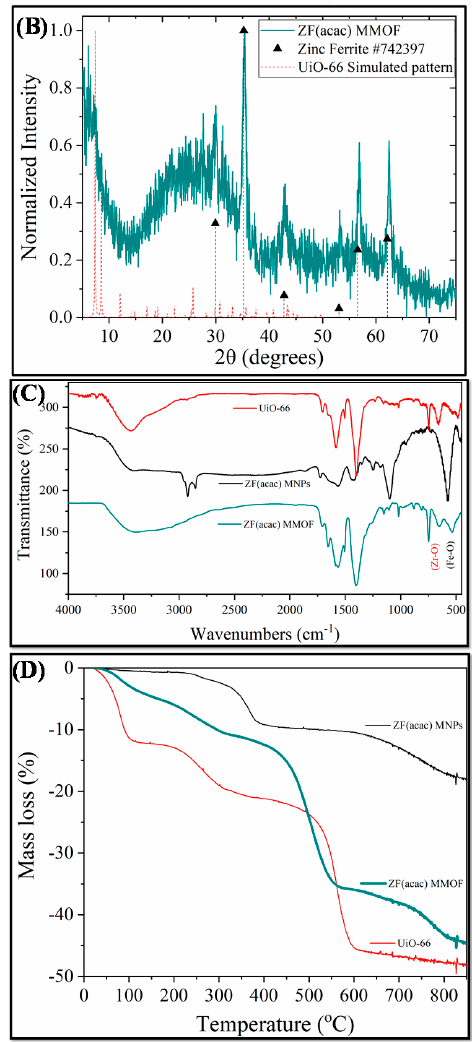
Figure 3. ( A ) SEM image; ( B ) XRD measurement; ( C ) FTIR spectrum; and ( D ) TGA of ZF(acac) MMOF.